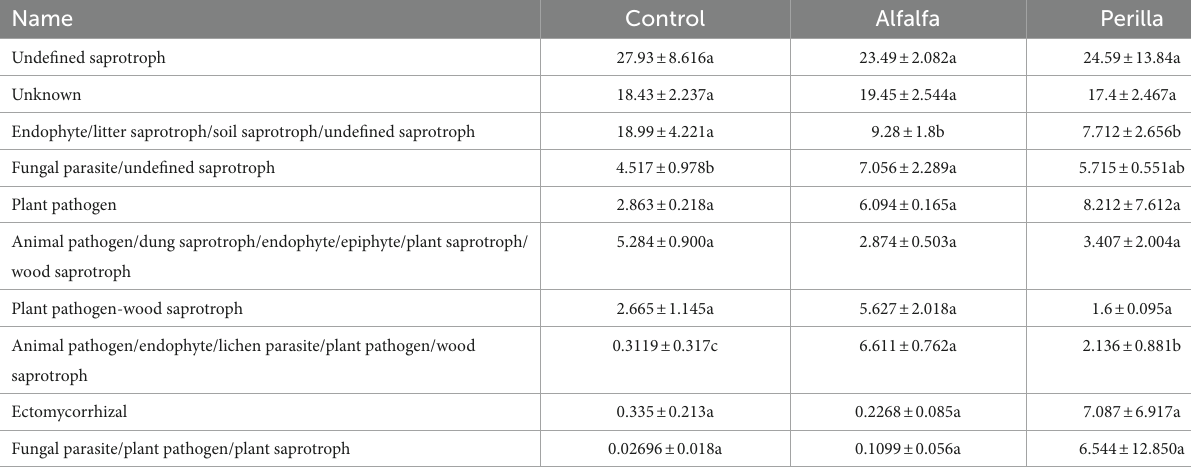
TABLE 1 Soil fungal function prediction in different treatments.